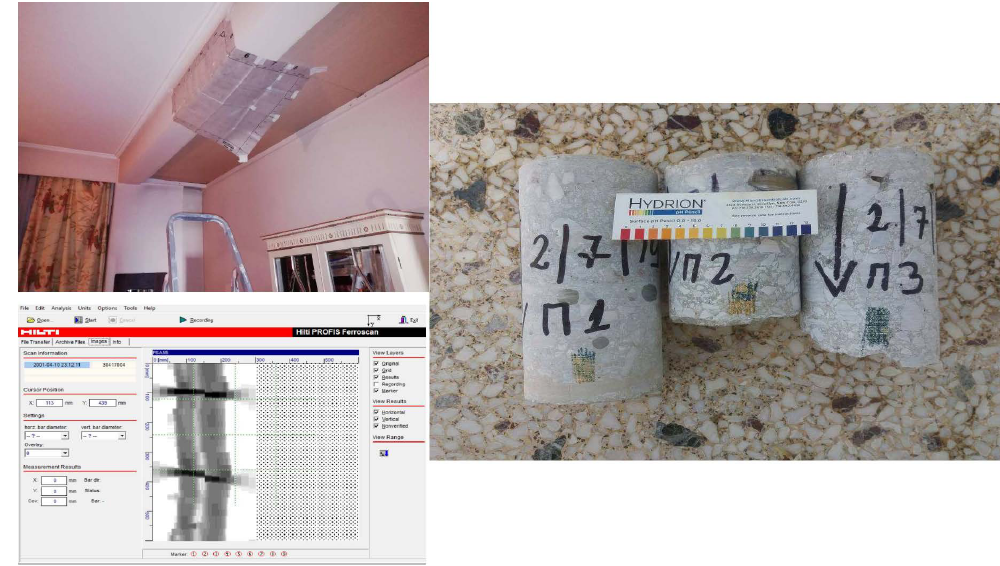
Figure 12. Building 2: Electromagnetic scanning of steel rebar in a beam and concrete